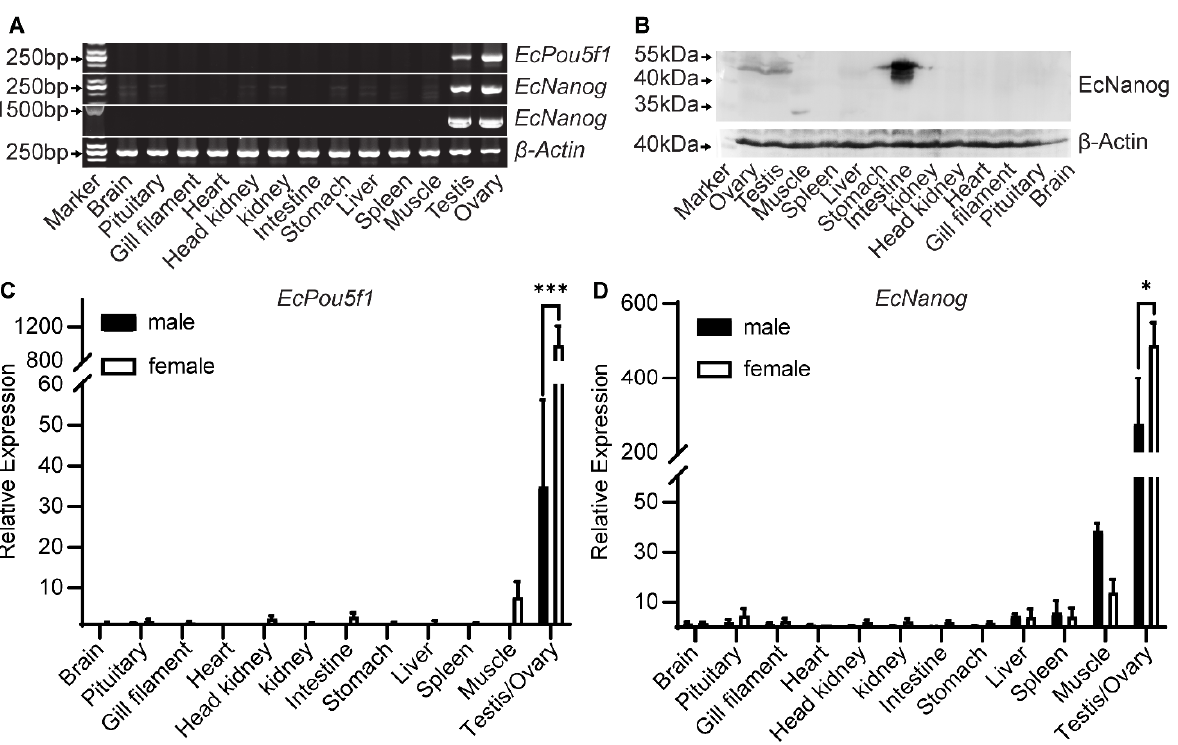
Figure 5. Expression pattern analyses of EcPou5f1 and EcNanog . ( A ) Semi-quantitative PCR analyses of EcPou5f1 and EcNanog in 13 tissues. The sizes of DNA fragments: EcPou5f1 , 245 bp; EcNanog , 240 bp, 1299 bp; β-Actin , 235 bp. ( B ) Western blotting analysis of EcNanog protein in 13 tissues. ( C , D ) RT-qPCR analyses of EcPou5f1 and EcNanog in 13 tissues. The data in C and D are presented as the mean ± SEM ( n = 3). The values with asterisks are significantly different with p < 0.05 (*) or p < 0.001 (***). The β-Actin was used as an internal control.